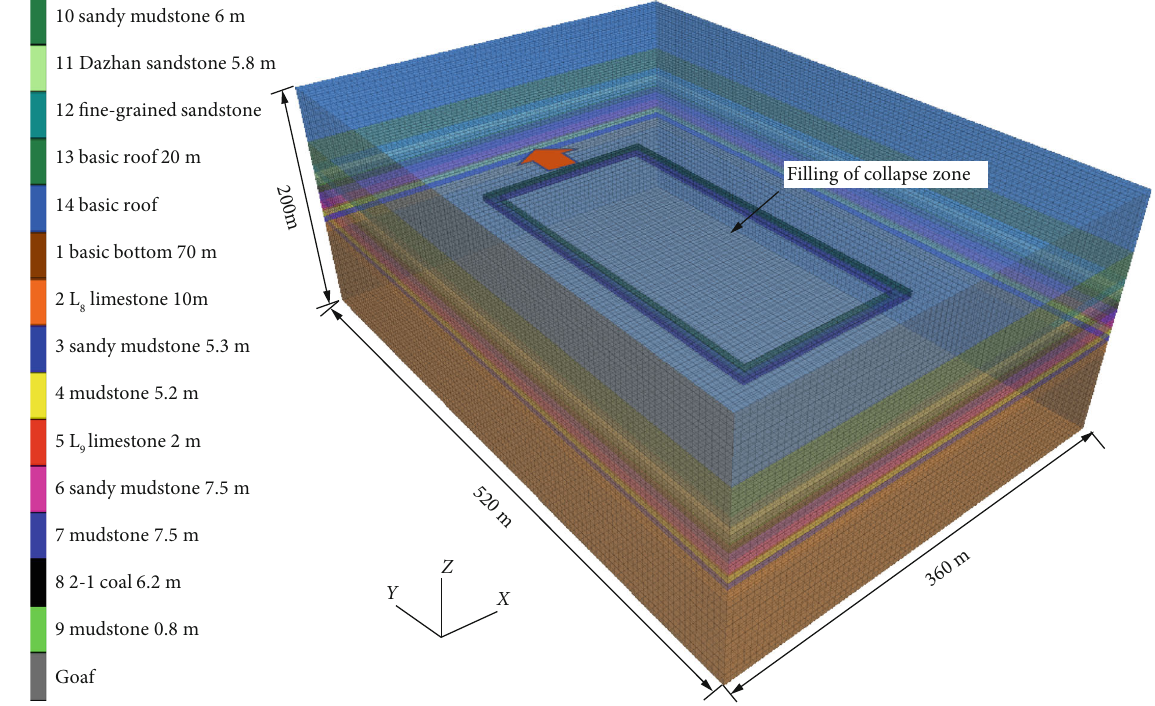
Figure 4: Numerical model of stress distribution of working face fl oor. Table 3: Rock mechanical parameters selected by the